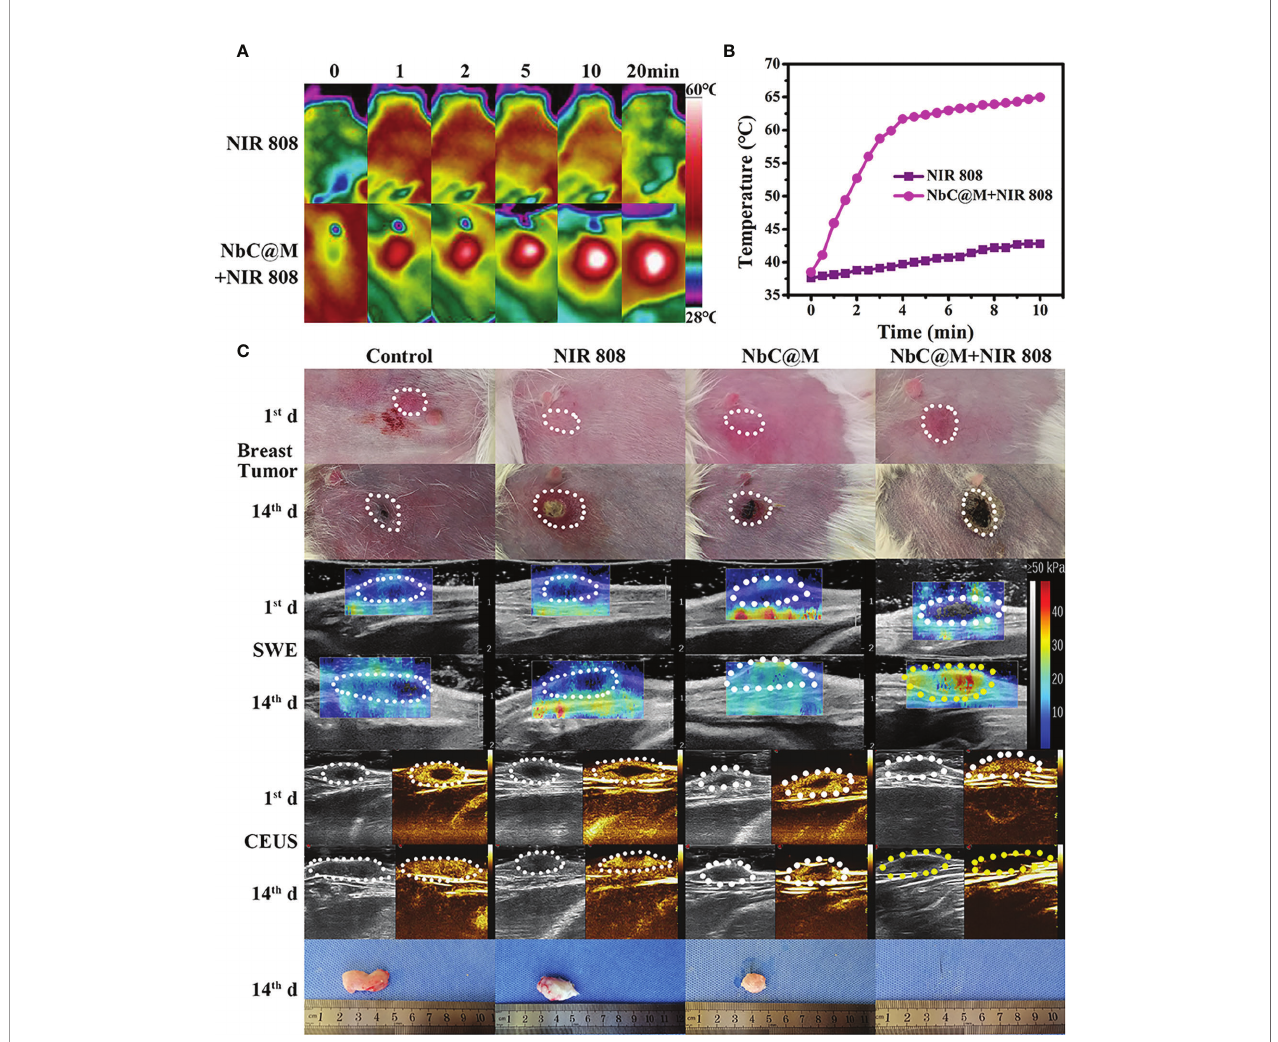
FIGURE 7 | In vivo phototherapy study of rabbits. (A) Photothermal images and corresponding (B) temperature variation at tumor site under NIR irradiation. (C) Representative photographs of tumor sites on rabbits and tumors, SWE and CEUS images of tumor